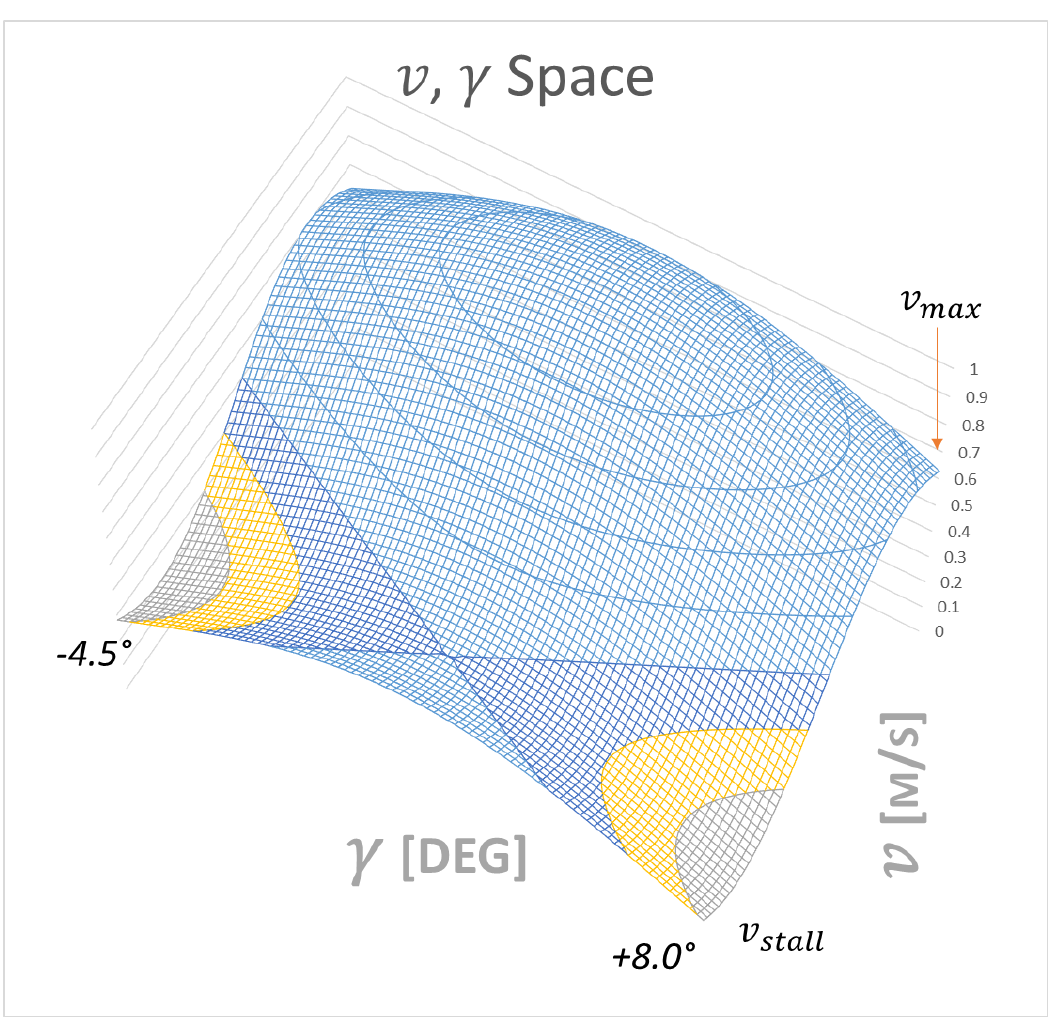
Figure 12. The T-S solution in 𝑣, 𝛾 space dominion.